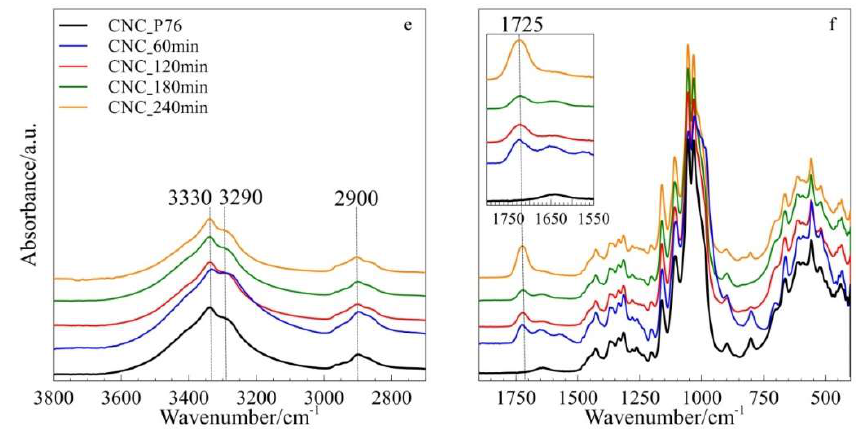
Figure 3. FTIR spectra of CNCs modified with succinic anhydride at various ( a , b ) SA:OH molar ratios; ( c , d ) temperatures and ( e , f ) times of reaction.